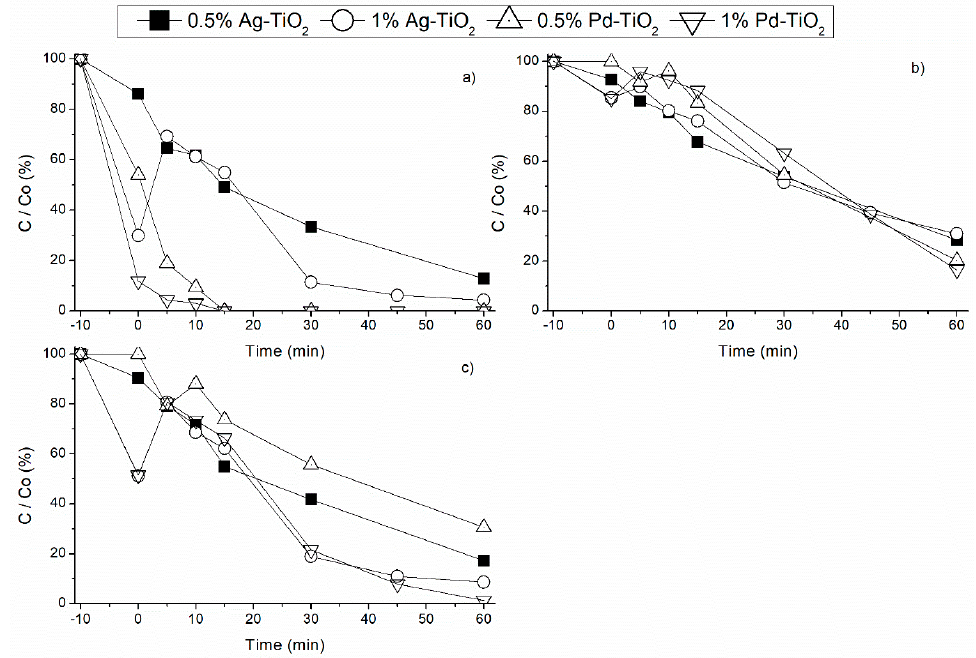
Figure 8. Contaminants’ (( a ) SMX, ( b ) CBZ and ( c ) LRZ) normalized concentrations during photocatalytic oxidation under UVA radiation.